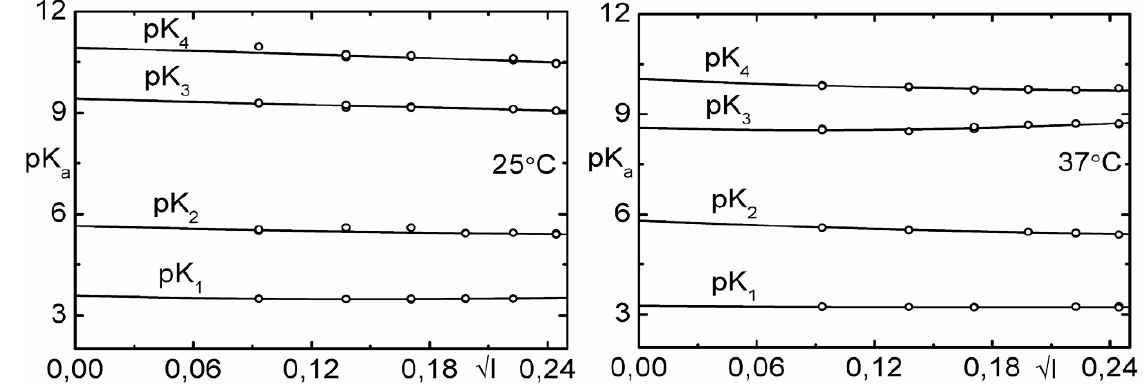
Figure 7. Dependence of the mixed dissociation constants pK